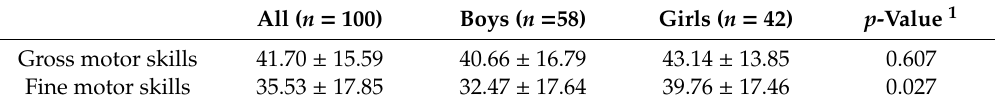
Table 4. Overall scores for the gross and fine motor skill (mean ± standard